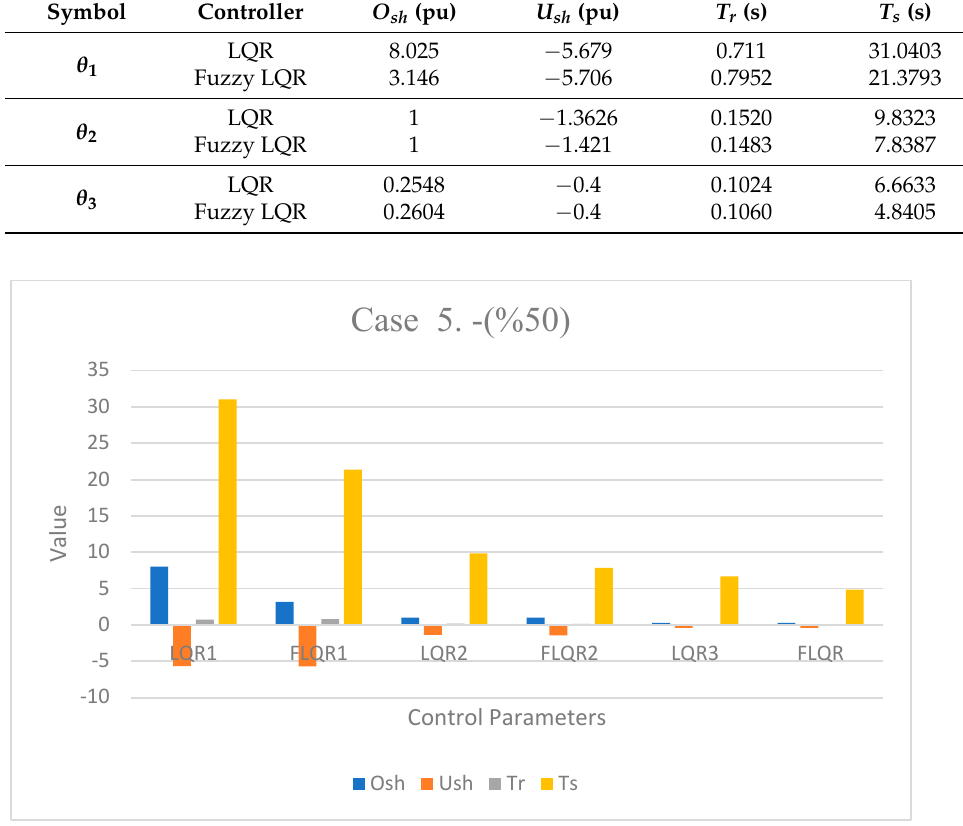
Figure 16. Case 4 comparison. Figure 16. Case 5